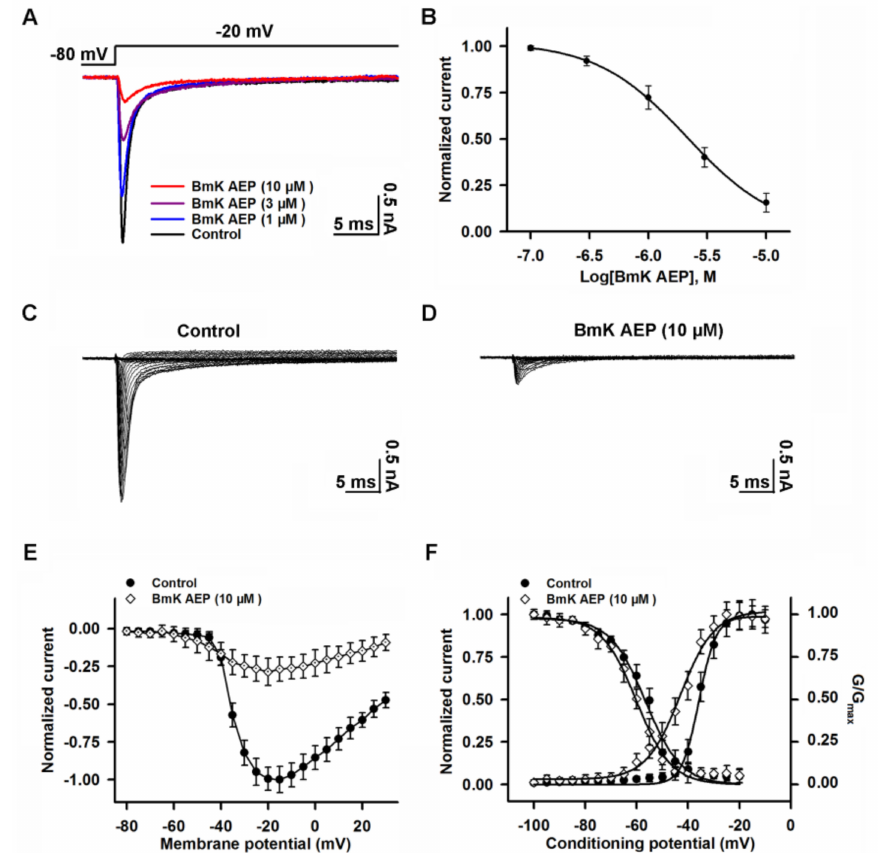
Figure 2. Influence of BmK AEP on voltage-gated sodium channel (VGSC) currents in primary cultured mouse cortical neurons. ( A ) BmK AEP inhibited the VGSC currents. Na + currents were elicited by a 50-ms depolarization to − 20 mV from the holding potential of − 80 mV. ( B )